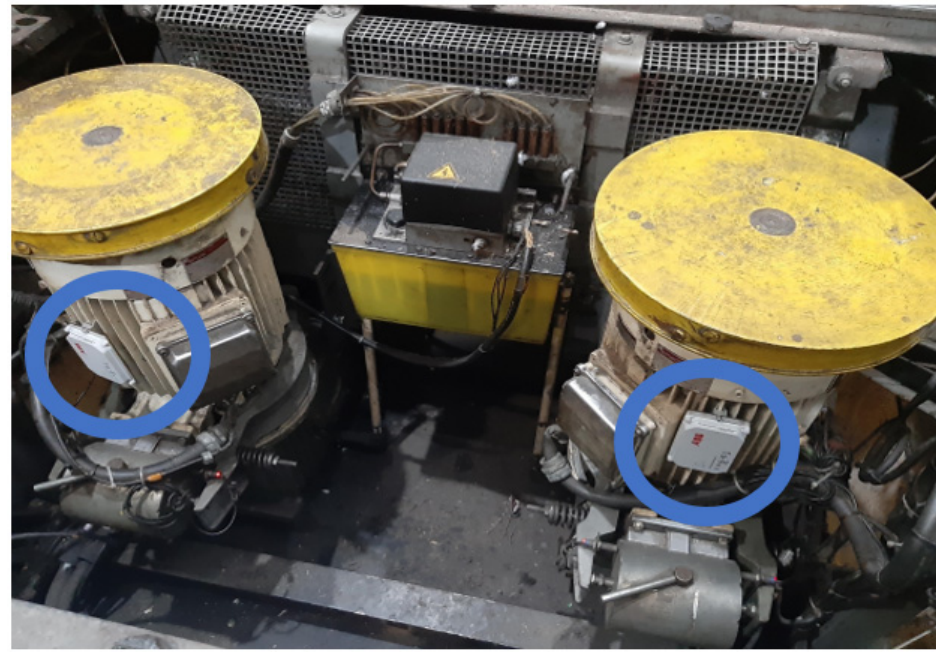
Figure 11. The electric motors of escalator are monitored by smart sensors.